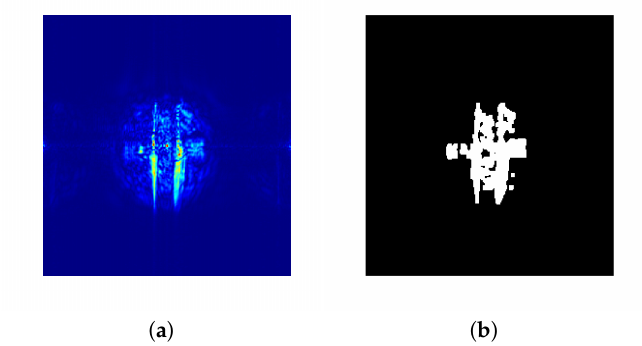
Figure 30. Two knives: ( a ) Scan; ( b ) Segmented image.